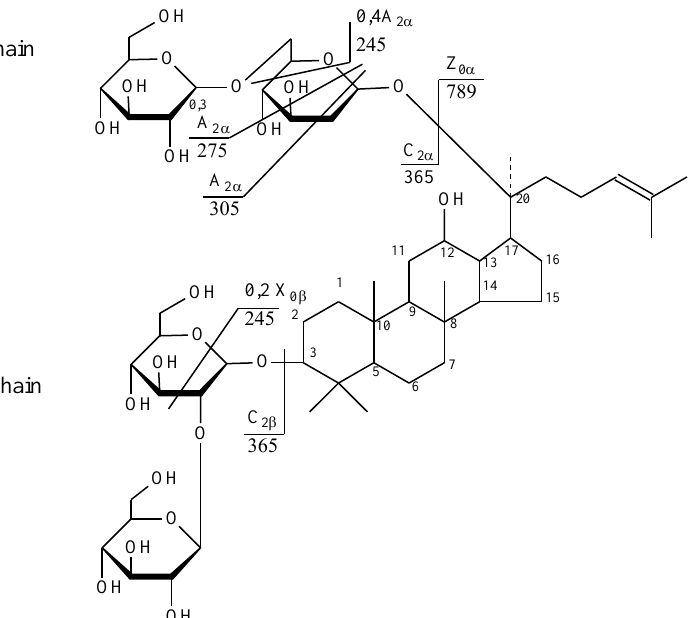
Figure 8. Structure of ginsenoside Rb 1 from wild ginseng (Russia).